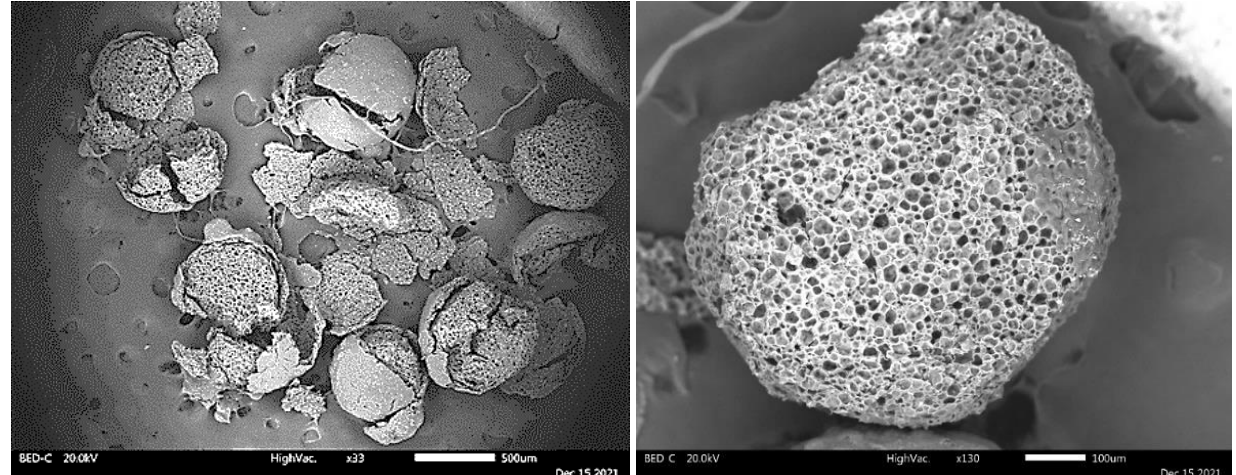
Figure 8. SEM images of the A-LMS Fe 3 O 4 /Se adsorbent.